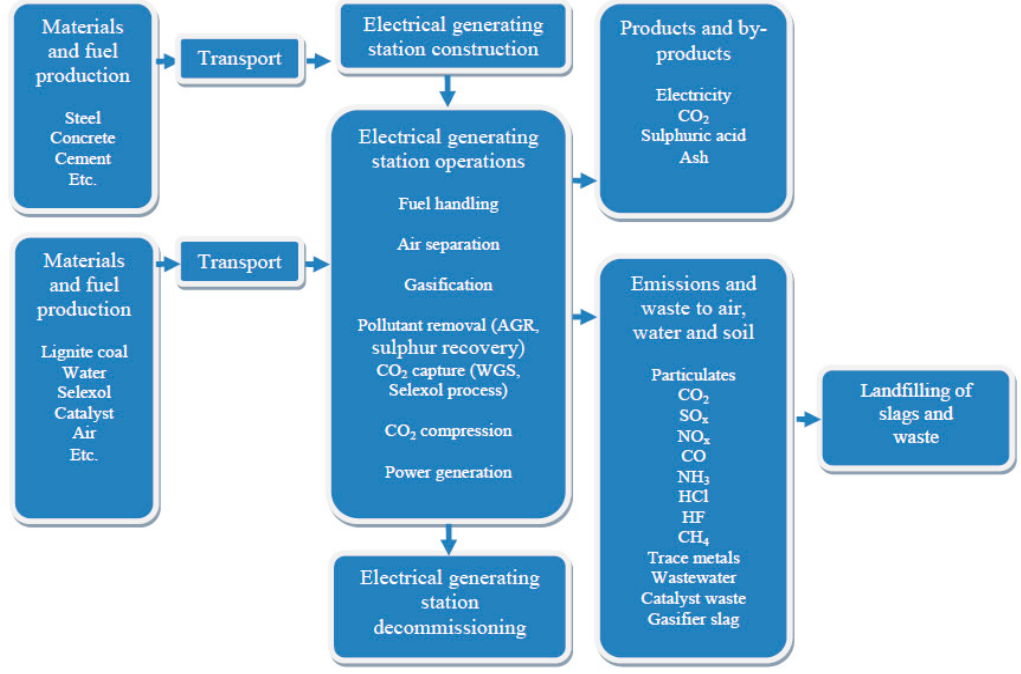
Figure 2. System boundaries for lignite-IGCC electrical generating station with pre-combustion capture.